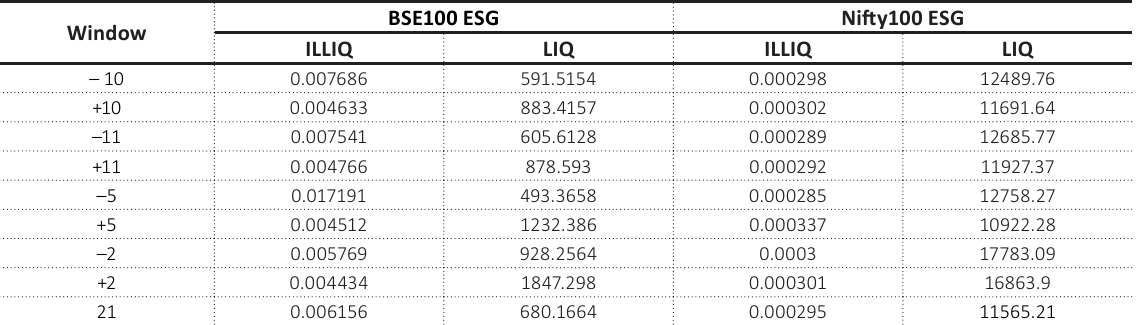
Table 6. Stock liquidity for the pre- and post-event